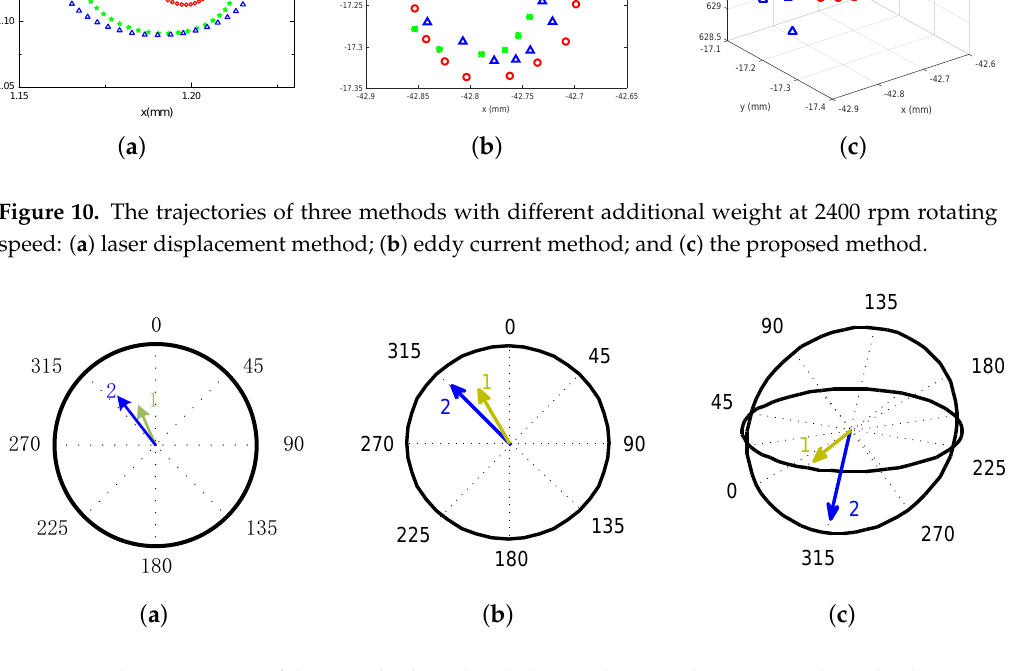
Figure 11. The comparison of three methods with unbalance schematic diagrams: ( a ) laser displacement method; ( b ) eddy current method; and ( c ) the proposed